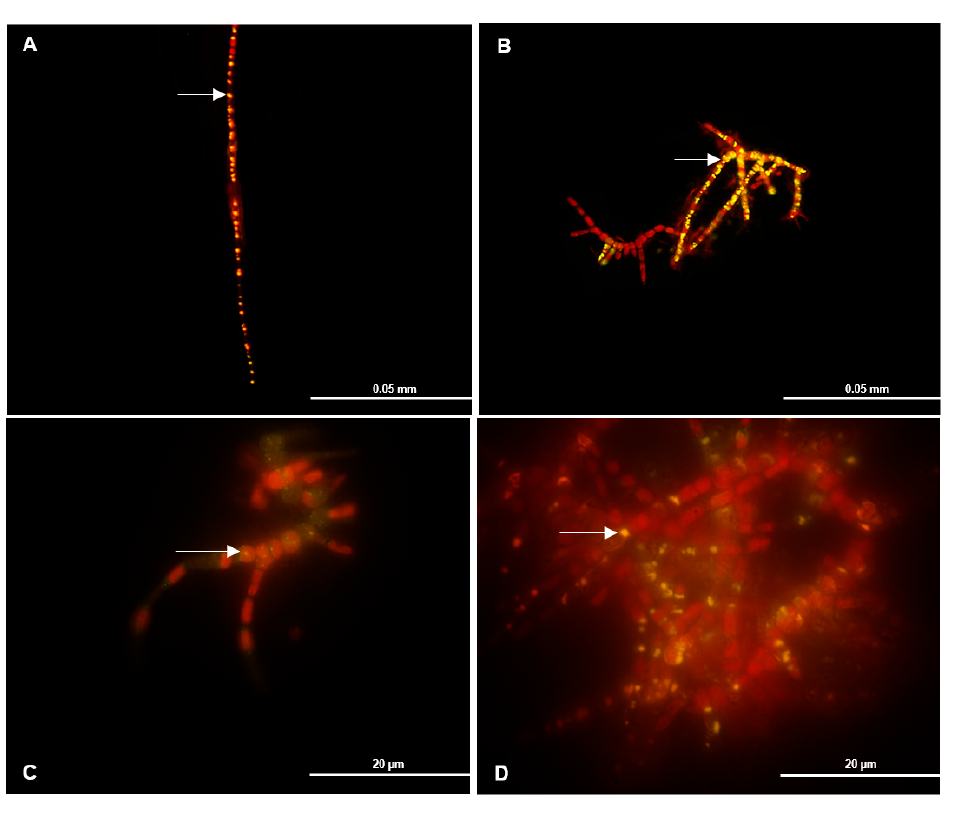
Figure 4. Polyhydroxybutyrate (PHB) in Stigeoclonium sp. B23 at day 6 ( A , C ) and day 12 ( B , D ) of cultivation. The arrows indicate where the yellow fluorescence was detected in the form of PHB granules after 12 days of cultivation. The PHB storage was not uniform in the filaments, but the highest amount of fluorescence was detected in no nitrate treatment; ( A , B ): no nitrate; ( C , D ): standard medium.